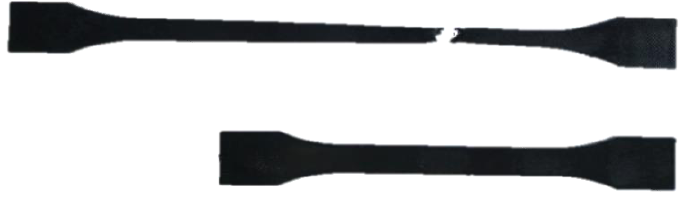
Figure 9. Example of the effect of the test on a specimen .